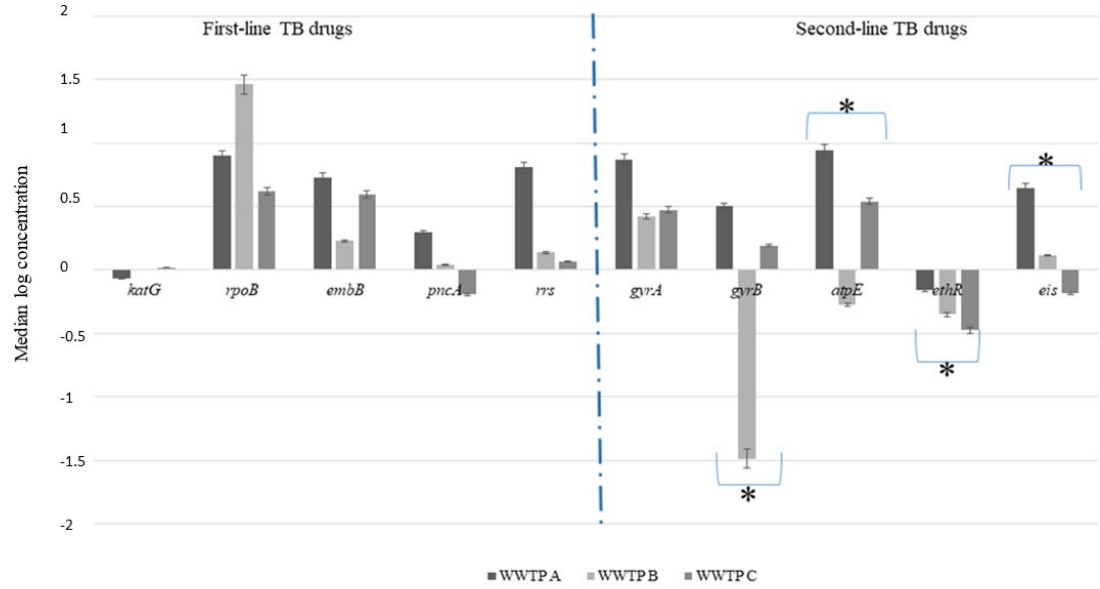
Figure 4. Median (SD) log reduction achieved for the various antimicrobial-resistance genes in the three wastewater treatment plants. * The difference in median log reduction for the ARGs marked was statistically significant, using the Kruskal–Wallis tests ( p -value ≤ 0.05).